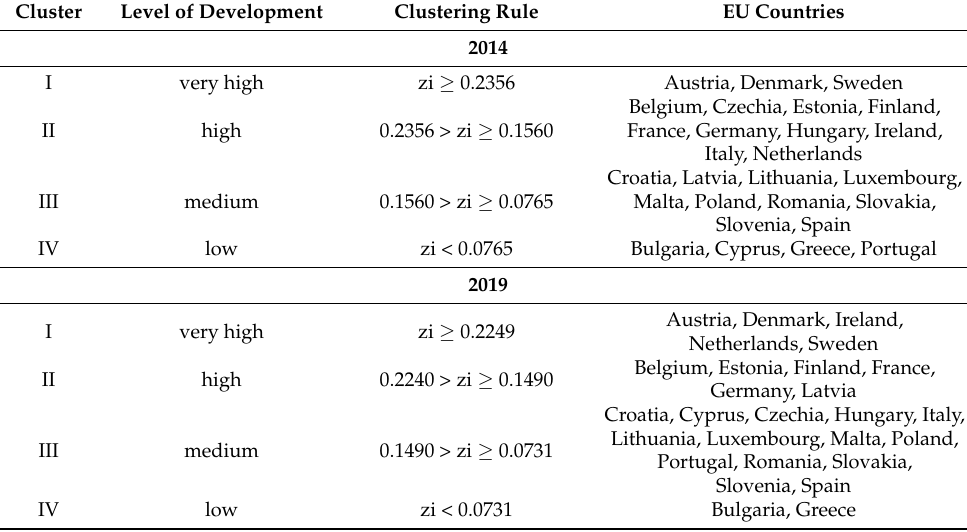
Table 4. Classification of EU countries into clusters: Hellwig’s method. Cluster Level of Development Clustering Rule